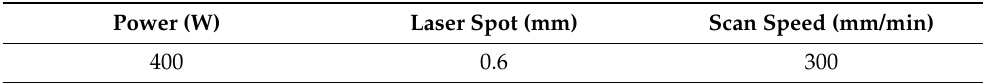
Table 5. Summary of the simulation parameters for the melting